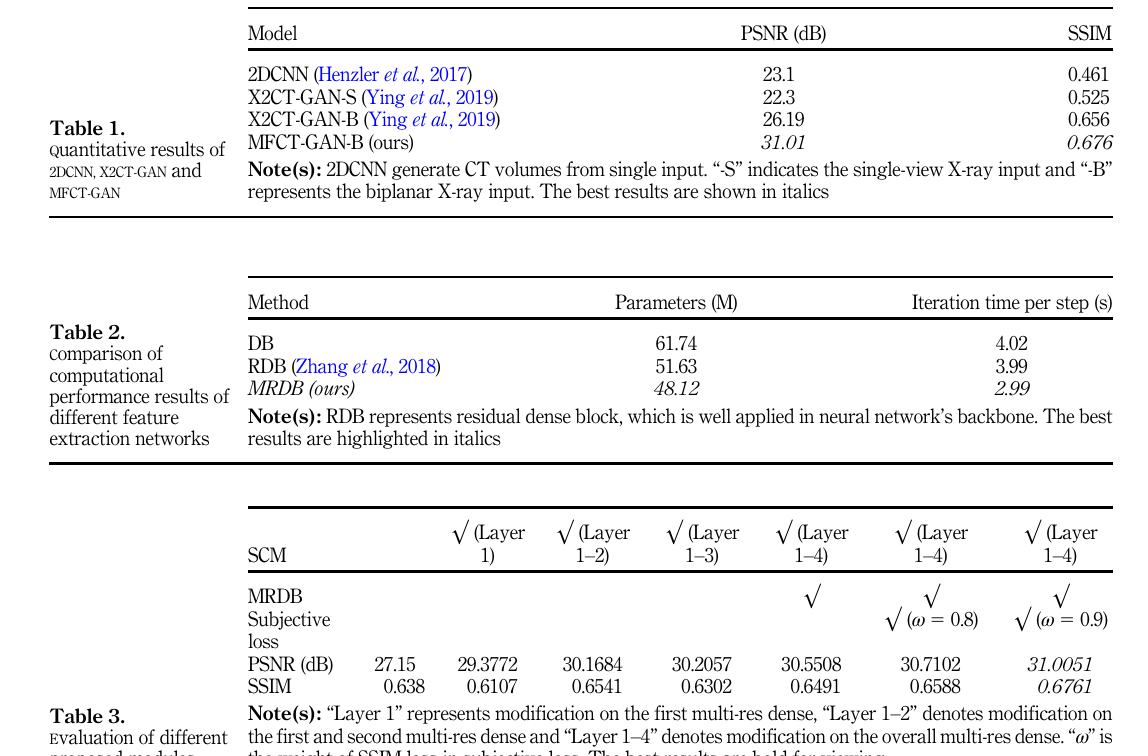
Table 3. E valuation of different proposed